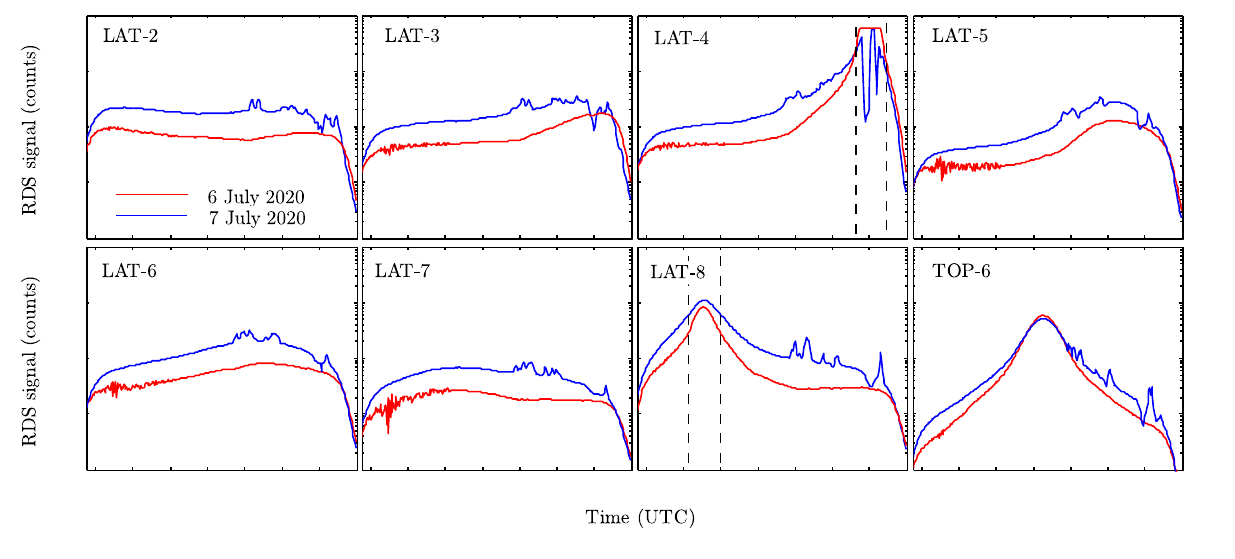
Figure 24. RDS LAT and TOP-6 sensors’ measurements in INTA/ARN on 6 (red solid line) and 7 (blue solid line) July 2020. The bands delimited by black dashed lines indicate the time intervals for which the Sun is near the sensors FoV.